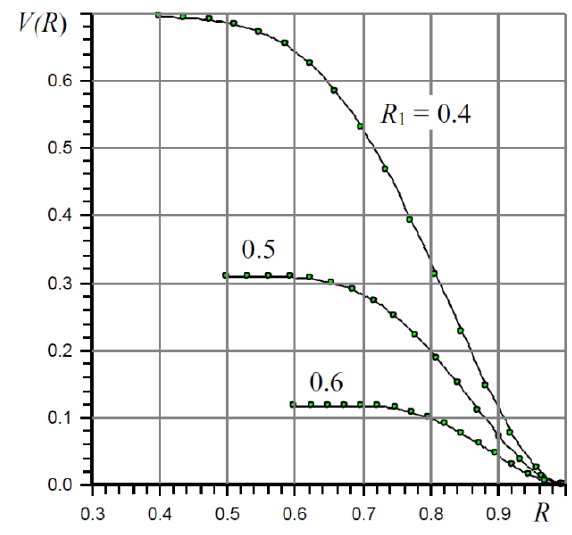
Figure 3. Curves of the dependence of the membrane deflection for different values of the radius R